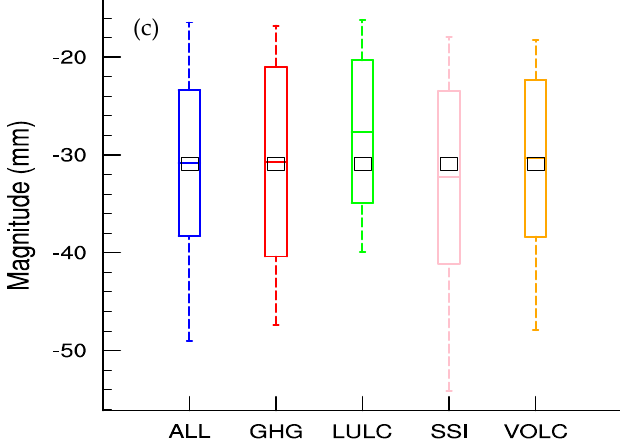
Figure 2. Comparison between reconstructed (black circle) and simulated megadrought lengths (( a ), unit: day), standardized magnitude (( b ), unit: 1), and absolute magnitude (( c ), unit: mm) from the control (CTRL) run (black square), all-forcing (ALL) runs (blue), greenhouse gases (GHGs) runs (red), land use and land cover (LULC) runs (green), spectral solar irradiance (SSI) runs (pink), and volcanic eruption (VOLC) runs (orange). The boxes indicate the 25th and 75th percentiles of the distributions. The bars within the boxes indicate mean values. The whiskers indicate the full range of the